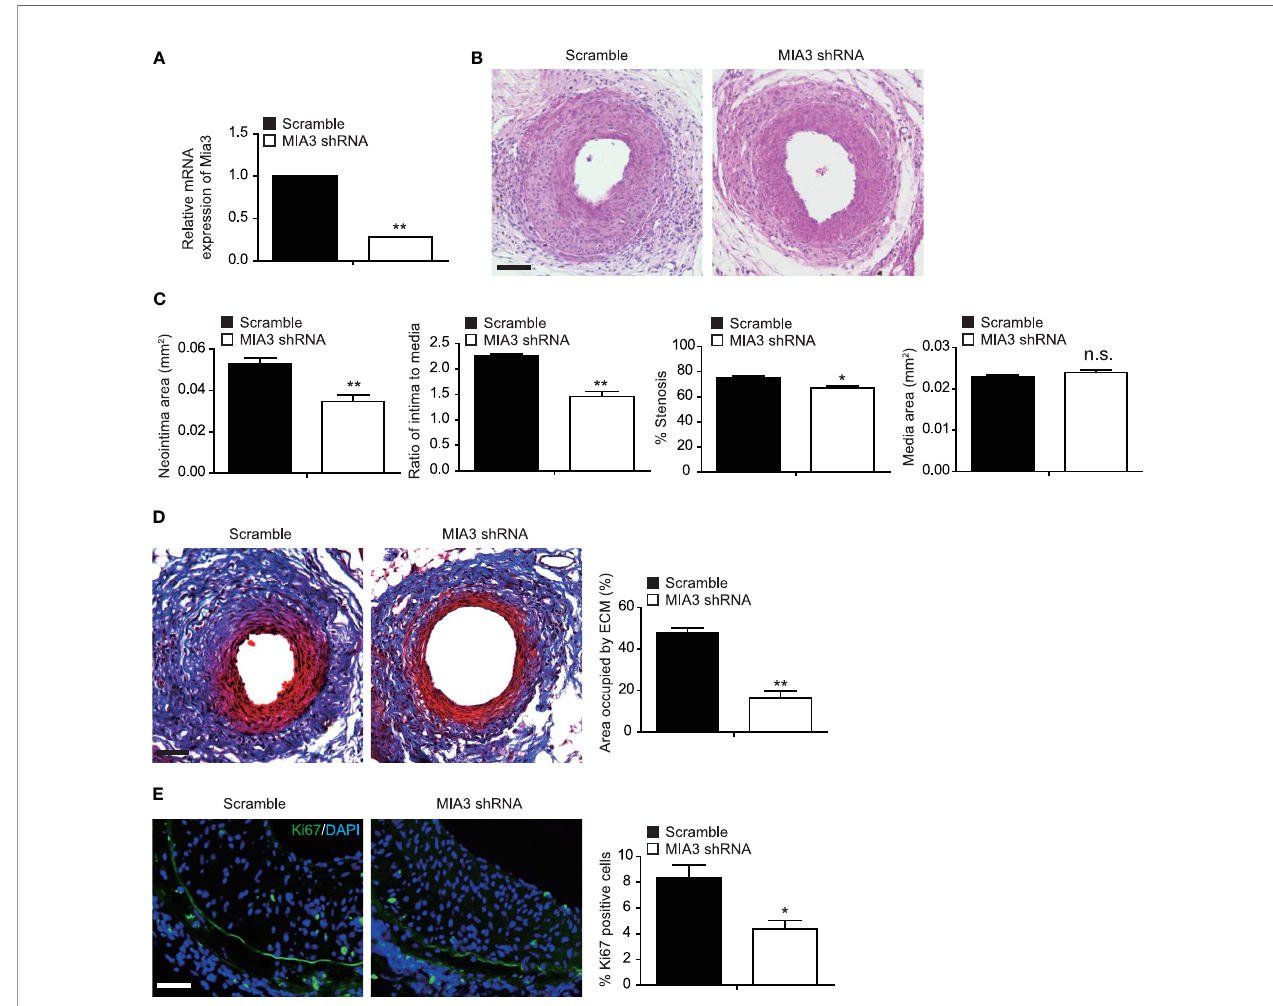
FIGURE 5 | Knockdown MIA3 ameliorates femoral artery wire injury-induced neointimal hyperplasia in mice. (A) Quantitative real-time reserve transcription polymerase chain reaction was performed to con fi rm the decreased expression of MIA3 in the injured femoral arteries. Data are represented as the mean ± SEM, n = 5. ** p < 0.01. t -test. (B) Representative hematoxylin and eosin (H&E) staining of mouse femoral arteries after wire injury for 28 days from mice infected with MIA3 shRNA lentivirus and scramble shRNA lentivirus. Scale bar: 100 m m. (C) The neointima area, intima-to-media ratio, % stenosis, and media area of wire-injured femoral arteries from mice infected with MIA3 shRNA lentivirus and scramble shRNA lentivirus. * p < 0.05, ** p < 0.01, n.s. indicates nonsigni fi cant. n = 5, t -test. (D) Representative Masson trichrome staining of mouse femoral arteries after wire injury for 28 days from mice infected with MIA3 shRNA lentivirus and scramble shRNA lentivirus, with quanti fi cation data on the right. Scale bar: 100 m m. Data are represented as the mean ± SEM, n = 5. ** p < 0.01. t -test. (E) Knockdown MIA3 with shRNA lentivirus exhibit a signi fi cant reduction of Ki67-positive cells in the neointima at 28 days after femoral artery wire injury, with representative images (left) and quanti fi cation data (right; n = 5 for each group). Data are represented as the mean ± SEM, n = 5. * p < 0.05. t